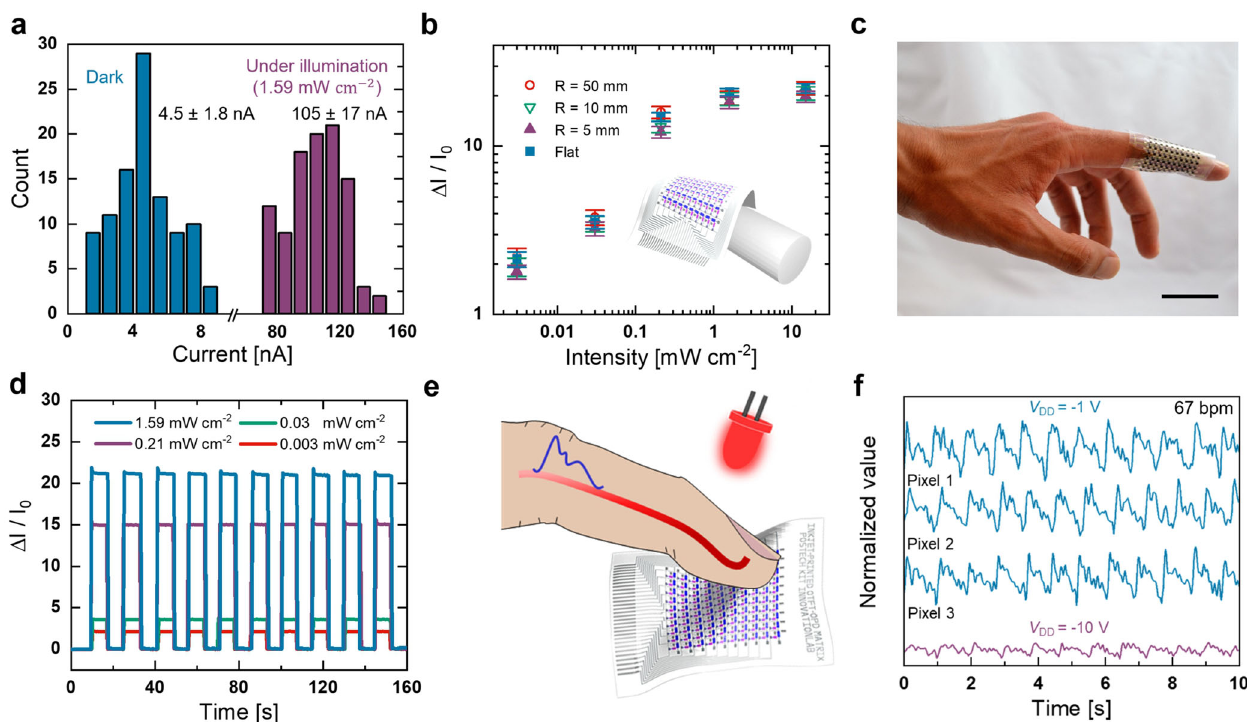
Fig. 5 Characterization of integrated devices. a Current distribution of 100 integrated devices. b Bending tests on integrated devices. The relative change in current is plotted against the light intensity for different bending radius. The bending radius (R) is de fi ned by different test structures fabricated for this experiment. Inset shows a schematic of the sample and a test structure. Error bars correspond to the standard deviation s.d. ( n = 3). c Photograph of fl exible active-matrix sample conforming to a fi nger (scale bar = 3 cm). d Dynamic current response. The relative change in current is plotted against time for different light intensities. Illumination was turned on and off for intervals of 10 s while the output current was recorded in real-time. e Schematic of fi nger pulse measurement in transmission mode. f Response obtained from fi nger pulse measurement in the saturation (V DD = − 10 V) and linear (V DD = − 1 V) regimes. A heartbeat value of 67 bpm was calculated from the